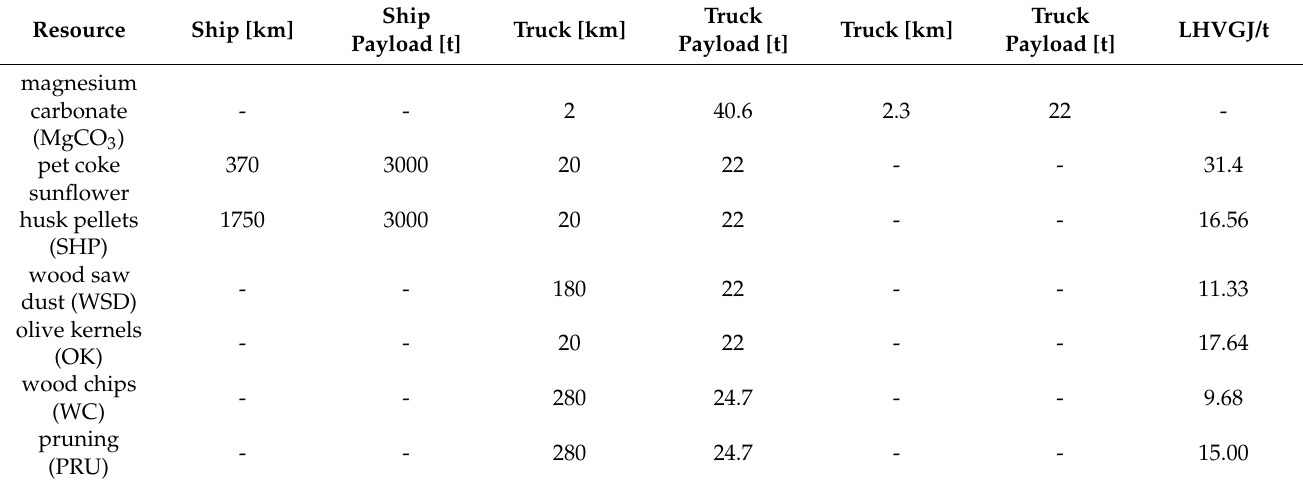
Table 3. Transportation routes and LHV of MgO production plant inputs